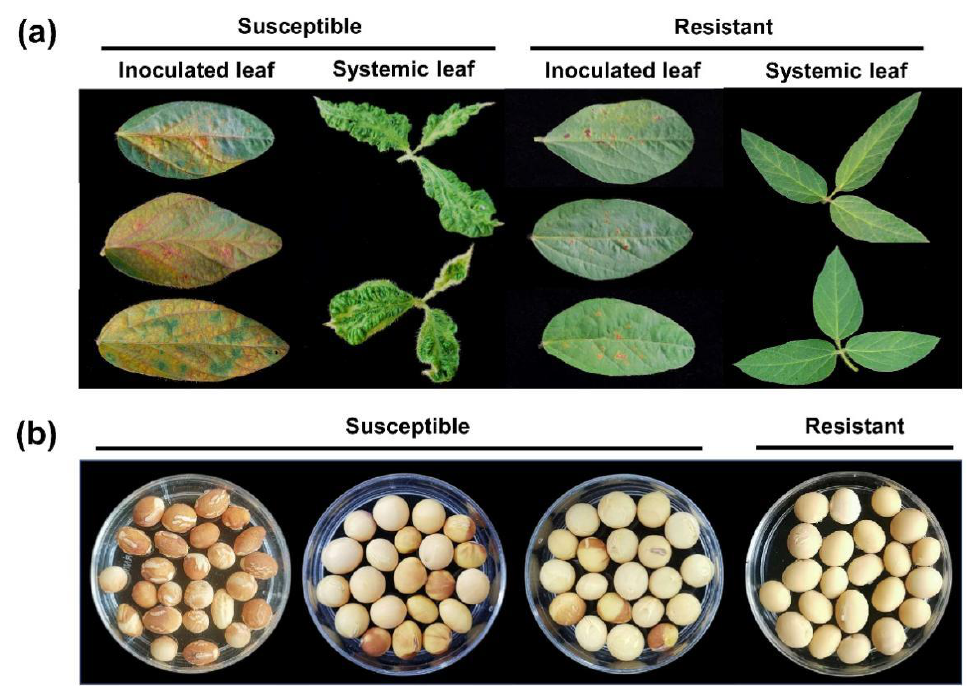
Figure 1. Different disease reactions of chromosome segment substitution lines (CSSLs) after inoculation of SMV N3 strain. ( a ) Leaf symptoms of CSSLs with susceptibility or resistance against SMV N3 infection; ( b ) seed symptoms of CSSLs with susceptibility or resistance against seed coat mottling.